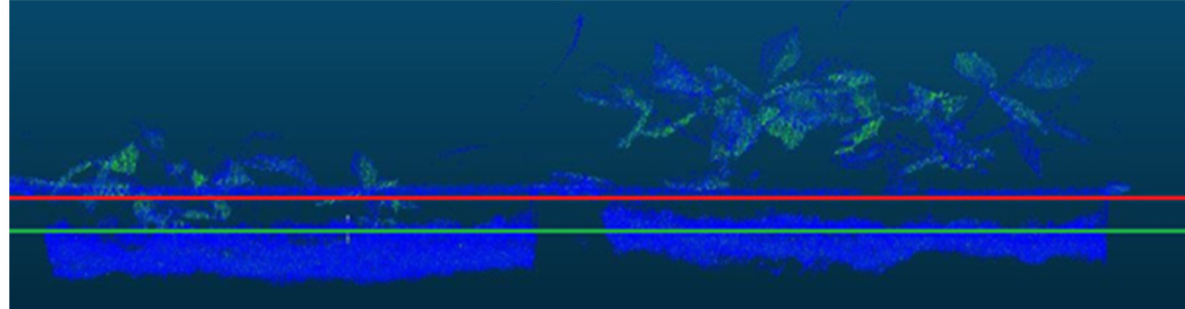
Figure 4. A partial view of a sample raw data with two soil separation lines. The red line points to the selected fixed height coordinate to separate the whole soil data, while the green line points to the other coordinate to keep as much plant data as possible. In the case of using the coordinate value pointed with the red line, it is seen that many plant data belonging to the left tray is lost. On the other hand, if the green line points to the coordinate, many soil data belonging to the correct tray cannot be cleared.